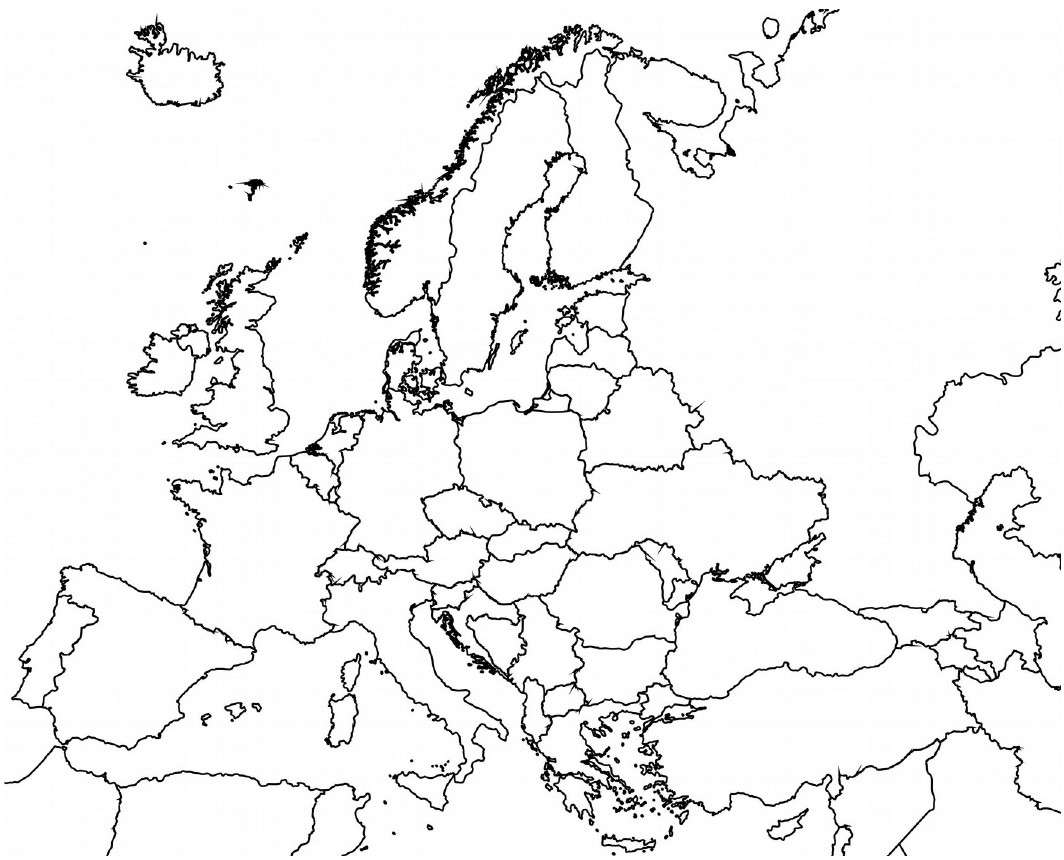
Fig 1. Map of Europe included in the questionnaire. The map was prepared using political boundaries from the dataset of thematicmapping.org.